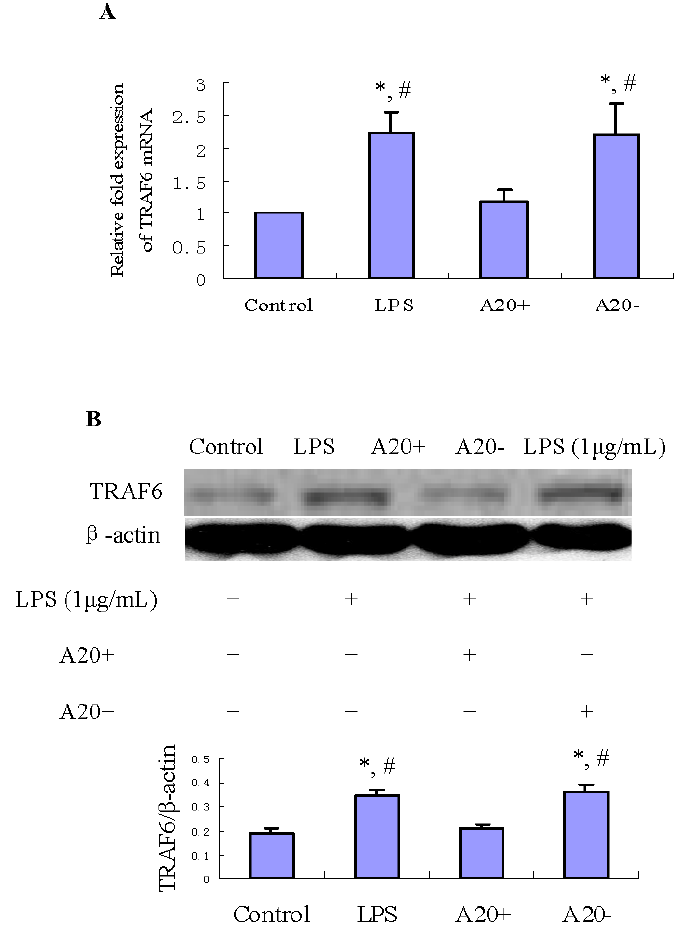
Figure 4. Effects of A20 on LPS-induced TRAF6 expression in RPMCs. Cells were pre-transfected with pGEM-T easy- A20 or pGEM-T easy for 24 h. Cells incubated with serum-free DMEM/F12 alone were used as the control. Near confluent cells were incubated with serum-free medium for 24 h to arrest and synchronize cell growth and then exposed to LPS (1 μ g/mL) for 1 h. RT-PCR and immunoblot analyses were performed to determine the mRNA and protein expression levels of TRAF6. The relative expression of TRAF6 protein was determined by normalization to β -actin. Results were obtained from three independent experiments. ( A ) Bar graph shows the expression of TRAF6 mRNA. Data are presented as the mean ± SD ( n = 3). * p < 0.01 vs. control; # p < 0.01 vs. A20+; ( B ) Bar graph shows the expression of TRAF6 protein. Western blots are representative of three independent experiments. Data are presented as the mean ± SD ( n = 3). * p < 0.01 vs. control; # p < 0.01 vs.